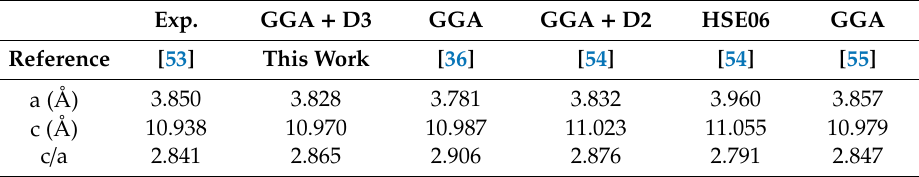
Figure 1. The hexagonal crystal structure of β -CuSCN. Table 1. Calculated lattice parameters of β -CuSCN in comparison with experiment and previous density functional theory (DFT)